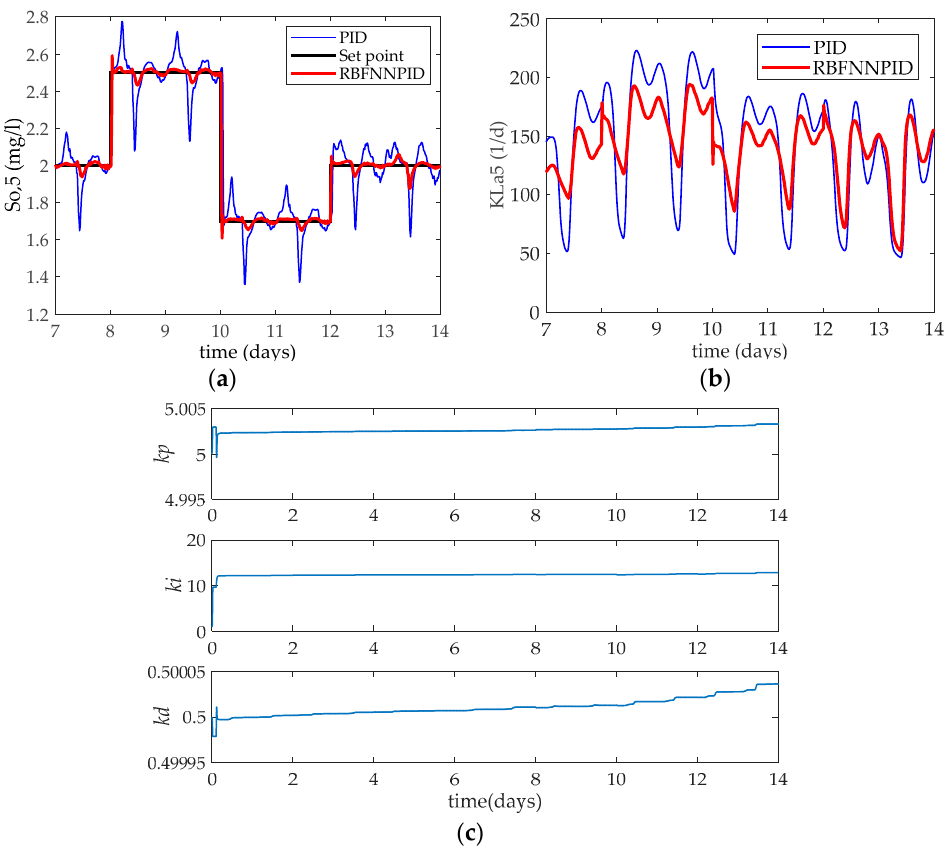
Figure 7. Comparison results of the tracking performance (changing set point of DO): ( a ) DO concentration in the fifth tank; ( b ) Dynamic changes of the manipulated variable K L a 5 ; ( c ) Dynamic adaptive adjustments of the three parameters kp , ki , kd of RBFNNPID algorithm.